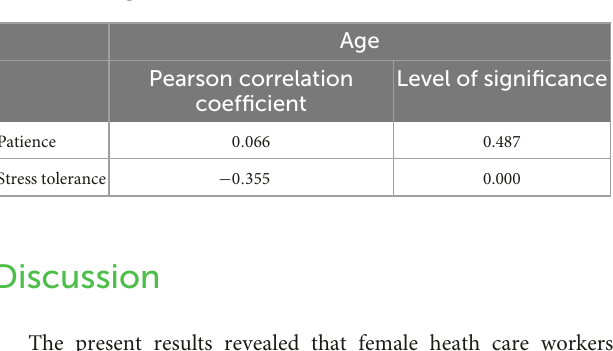
TABLE 8 Pearson’s correlation coefficient between patience, stress tolerance, and